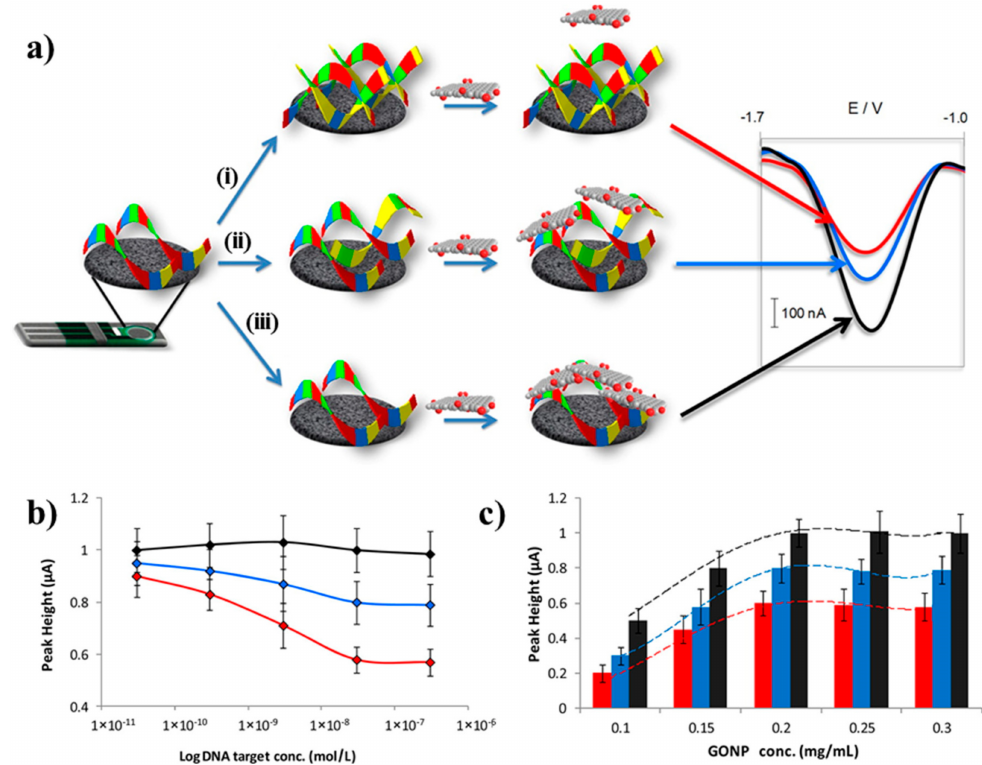
Figure 11. ( a ) Schematics of the experimental protocol, (i) after complementary target hybridization, (ii) one–mismatch target, and (iii) non–complementary target. ( b ) Voltammetric response towards different target DNAs in the case of hybridization with wild–type (red line), mutant (blue line), and non–complementary (black line). ( c ) Voltammetric signal for conjugation with different amounts of GO NPs in the case of hybridization with wild–type (red bars), mutant (blue bars), and nc (black bars) sequences (n = 3). Reproduced with permission from Ref. [63]. Copyright (2012) American Chemical